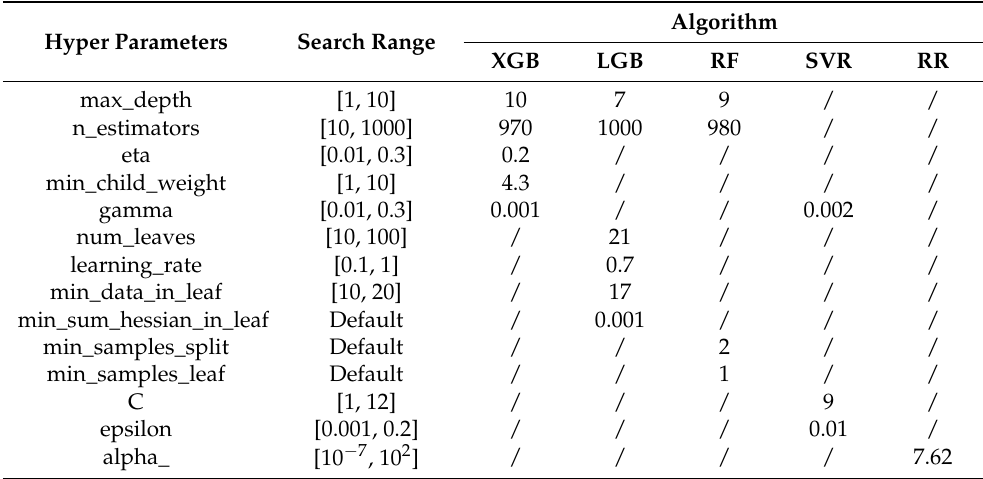
Table 6. Hyper parameters of the models.